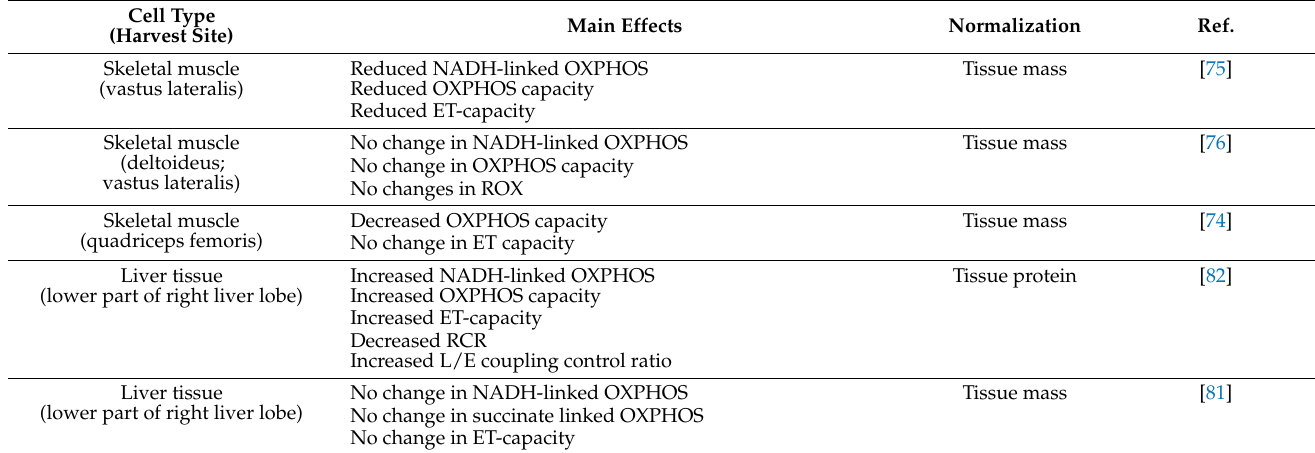
Table 4. High-resolution respirometry findings in human obesity